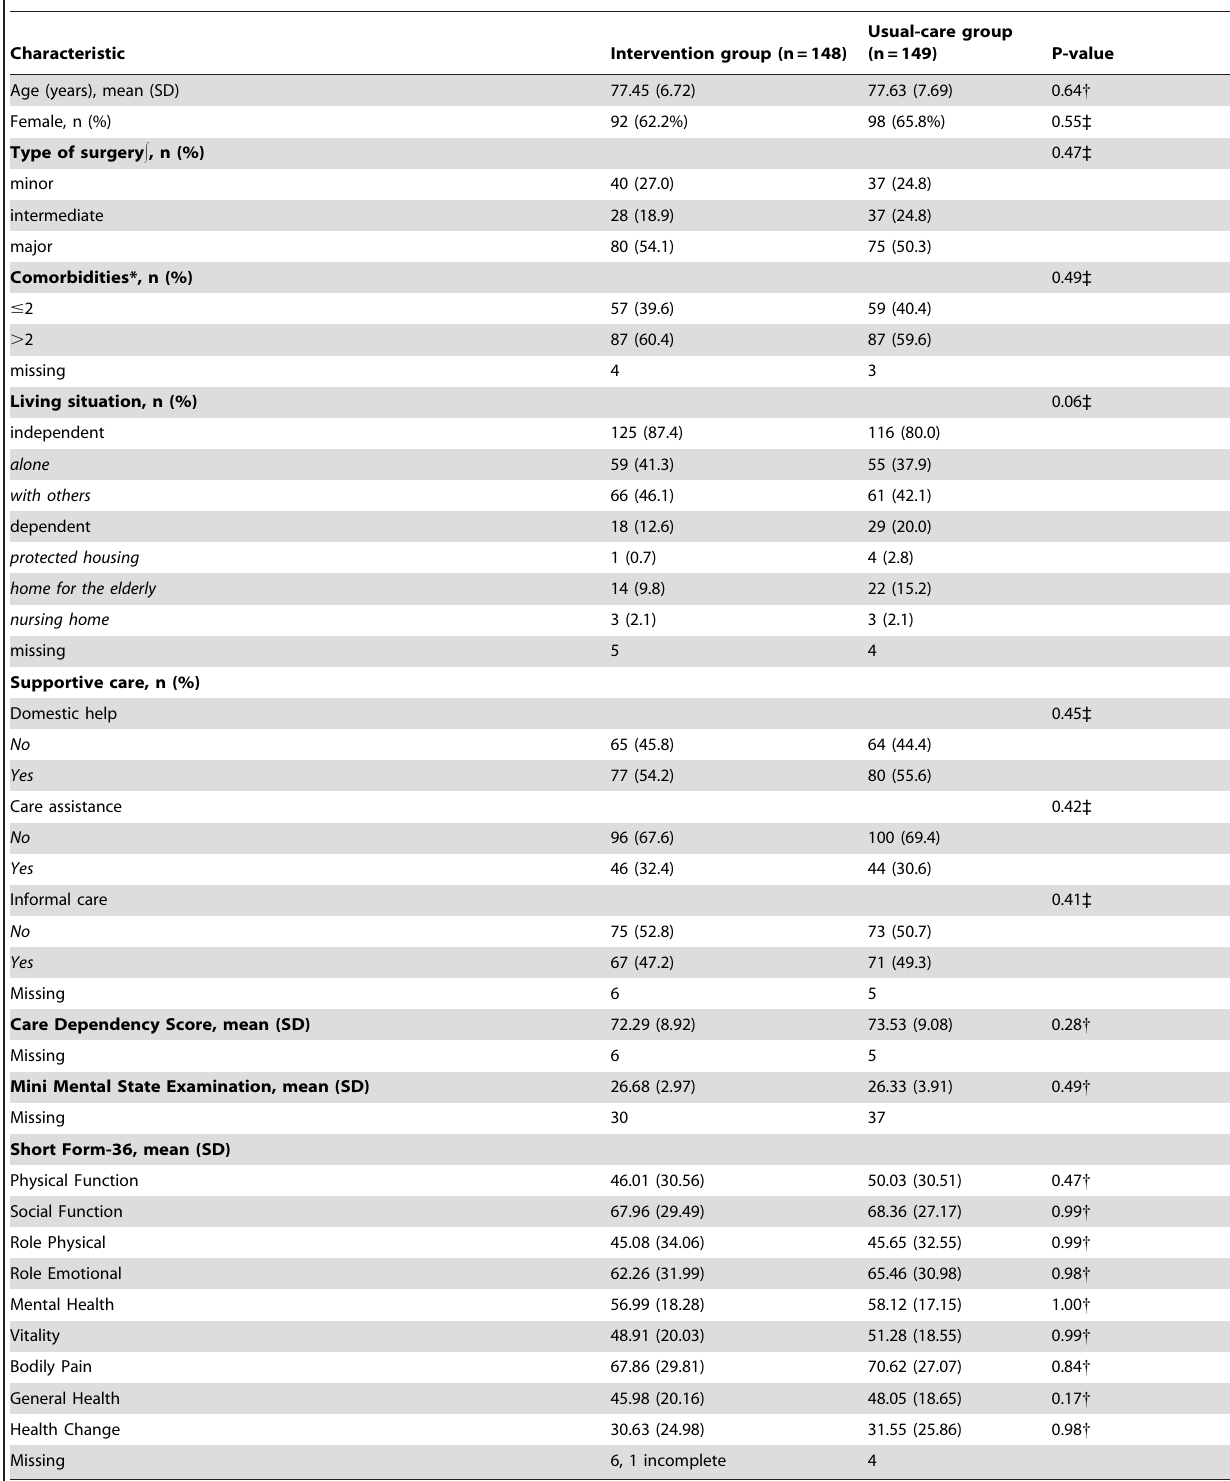
Table 3. Baseline characteristics of the patients at inclusion according to study group.